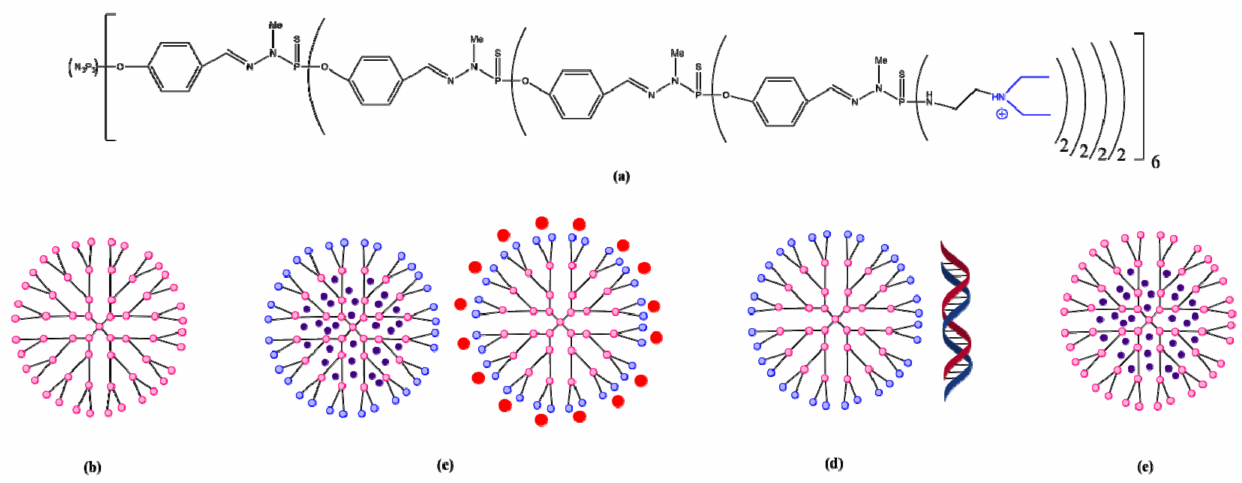
Figure 9. Dendrimer 6-G4, used as a support for the delivery and release of therapeutic genes ( a ) 6-G4 dendrimer; ( b ) active dendrimer; ( c ) dendrimer as drug carrier; ( d ) dendriplex; ( e ) active dendrimer as drug carrier. Adapted from [33], published by Molecules